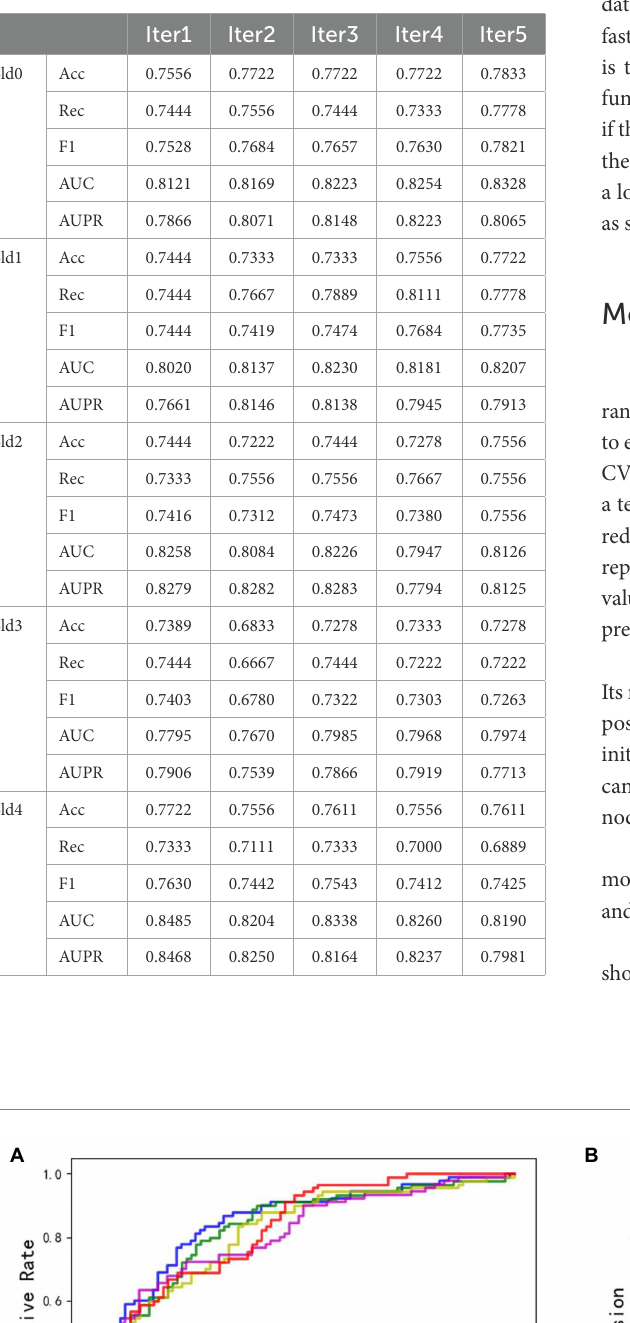
TABLE 2 The summary of model performance under 5-fold CV.